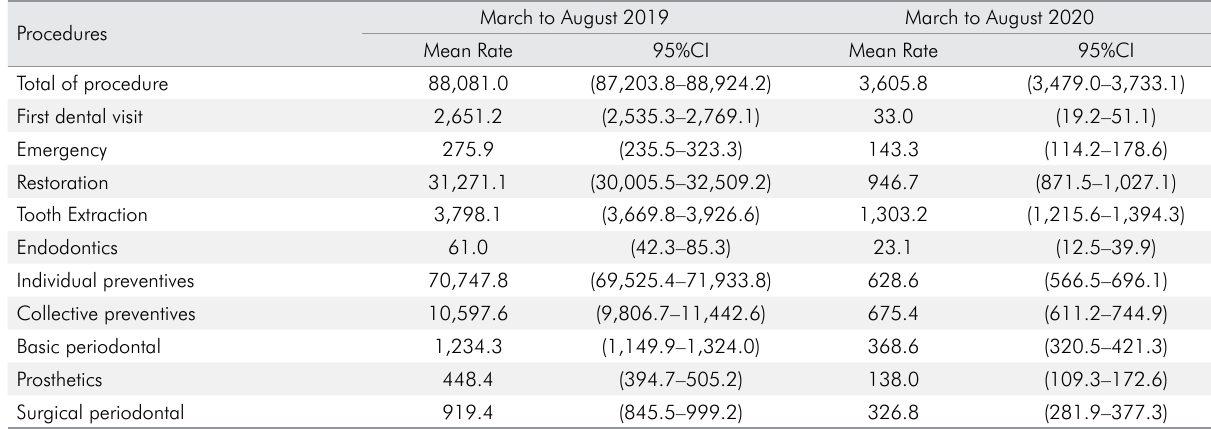
Table 4. Average monthly procedures rate (per 100,000 inhabitants) and respective 95% confidence intervals (95%CI) of March to July according to different group procedures. (n =